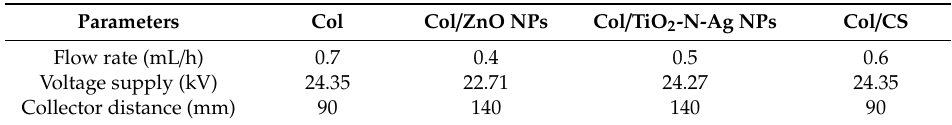
Table 2. Electrospinning parameters for processing of antimicrobial collagen rabbit skin collagen